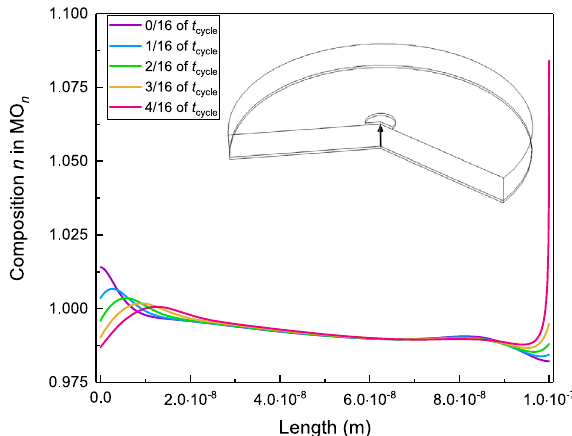
Figure 9. Concentration profiles of the oxygen ions along the rotational axis of the device for a 2D rotational symmetric simulation with basic parameters (see Table 1) and a BE with ( 1.0 × 10 − 6 m ) 2 . The BE is at 0 m while the TE is at 1 × 10 − 7 m. This is only the first quarter of a steady I – V